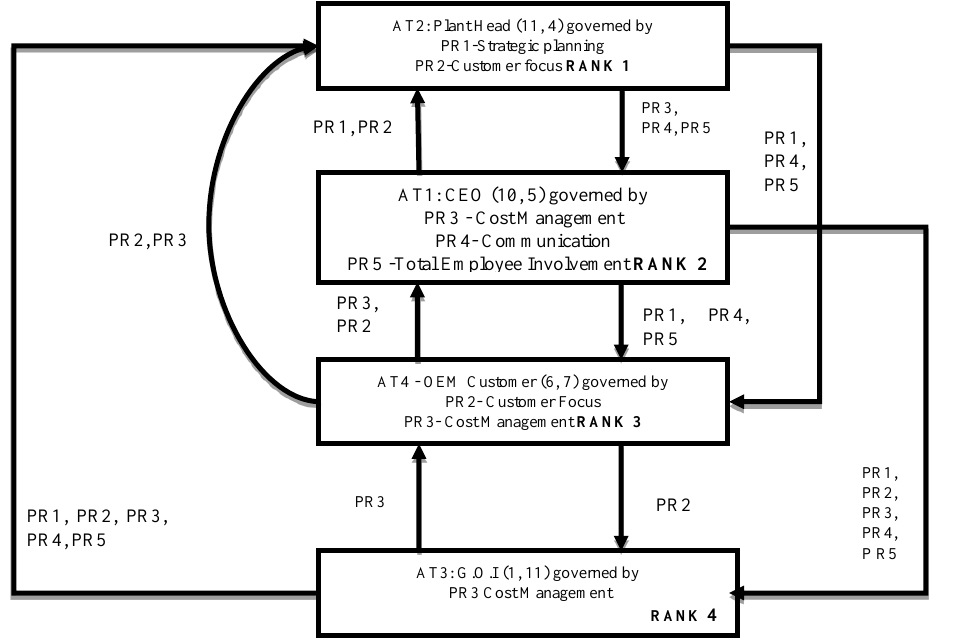
Figure 1. IRP model for actors with reference to process.